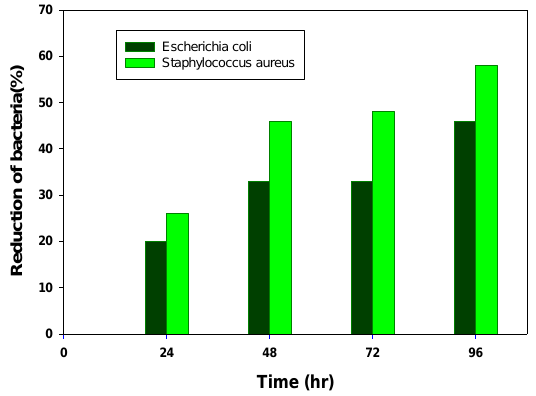
Figure 3. The rate of bacteria reduction in SOJ-coated PHB fibers membrane during 96 h of experiment, based on the dilution method.